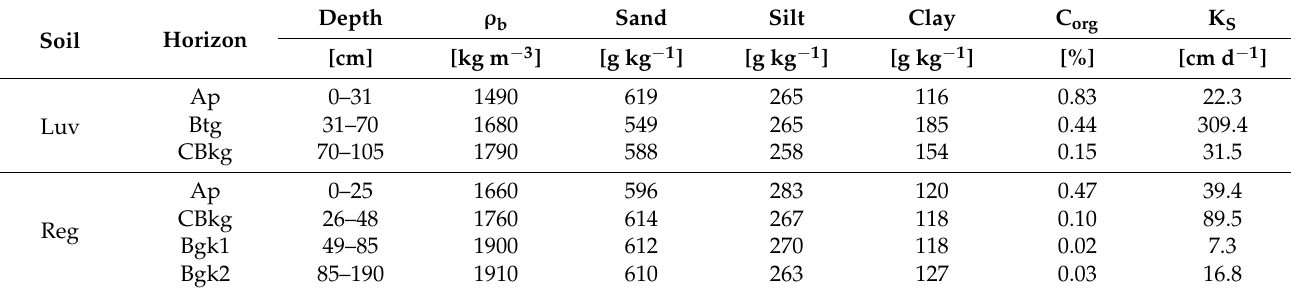
Table 1. Soil physical and hydraulic parameters of the Luvisol (Luv) and Regosol (Reg) adapted with permission from [27] (2012 Elsevier B.V.): ρ b –soil bulk density; soil texture classes: sand (2–0.063 mm), silt (0.063–0.002) and clay (<0.002 mm); C org –organic carbon content; K S –soil hydraulic conductivity (RETC-fitted with the van Genuchten-Mualem model).